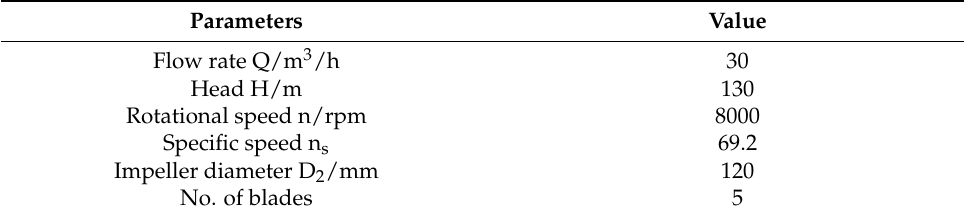
Figure 1. Schematic diagram of a high-speed magnetic drive pump. 1—volute, 2—inner magnetic rotor, 3—containment shell, 4—outer magnetic rotor, 5—connector, 6—motor. Table 1. Parameters of the magnetic drive pump.